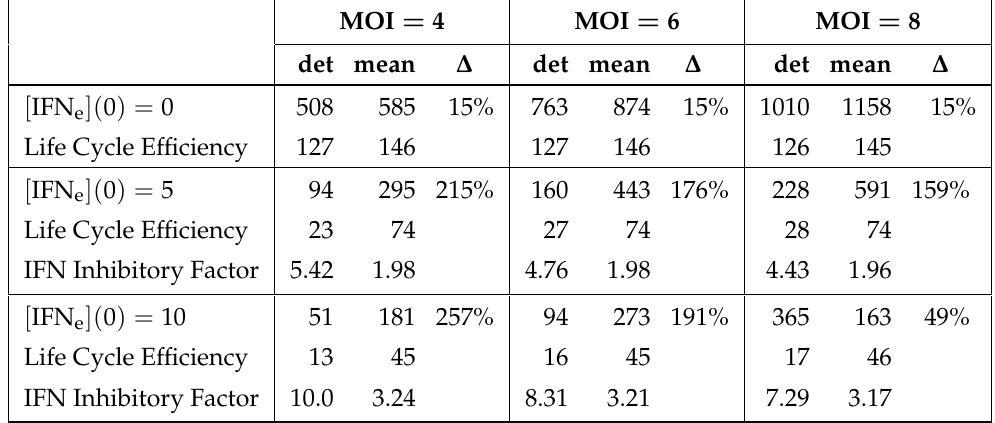
Table 2. The number of total virions released from a single infected cell during the infection process for different values of [V free ](0) (MOI) and [IFN e ](0) (molecules). Here, “det” denotes the outputs in the deterministic process, “mean” denotes the mean values in the stochastic process, and ∆ means the excess of the mean stochastic outputs over the deterministic outputs in percent. The “Life Cycle Efficiency” is defined by Equation (40). “IFN Inhibitory Factor” is defined by Equation